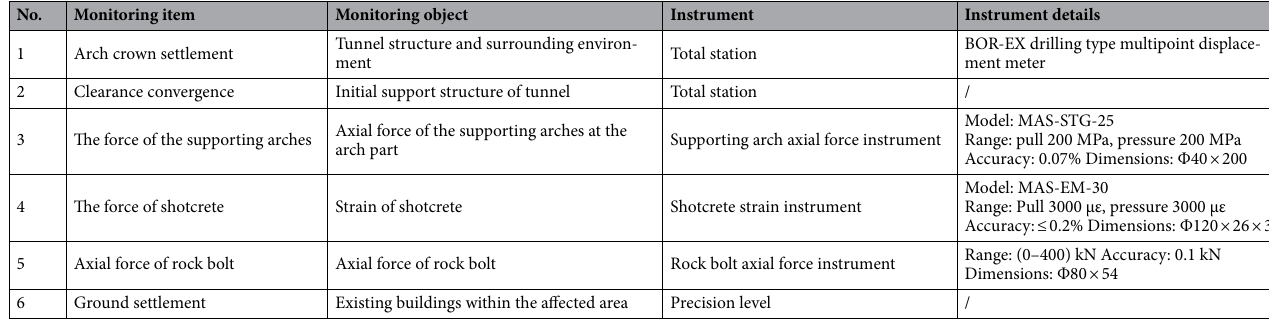
Table 11. Summary of monitoring items.